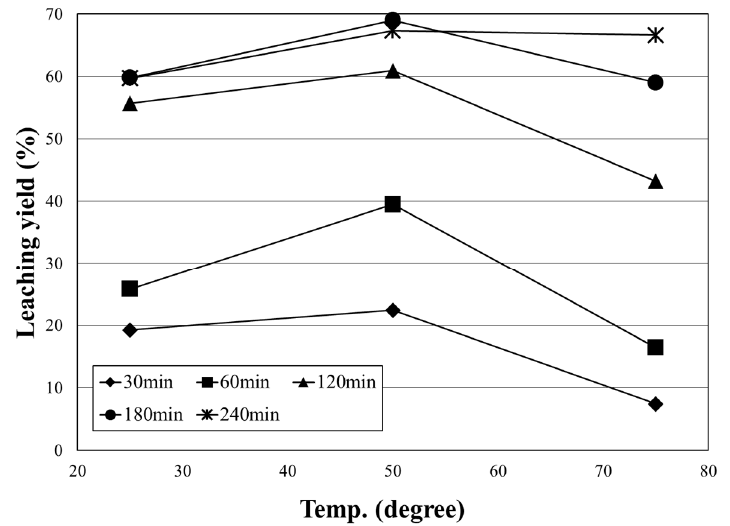
Figure 7. Leaching yield of molybdenum at various temperatures (current density: 0.292 A/g, pulp density: 5%).